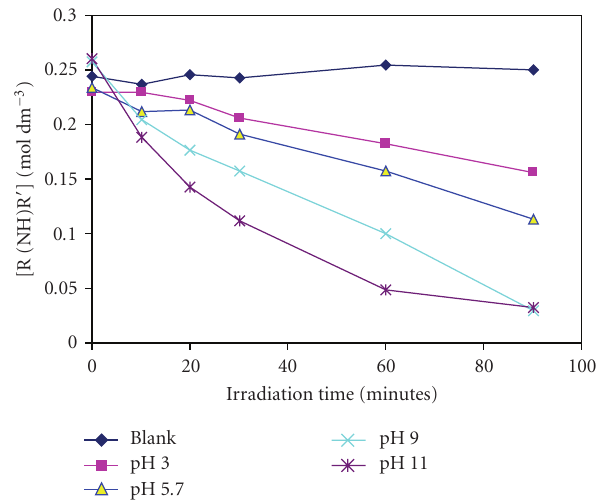
Figure 2: Photocatalytically induced loss of secondary amine functionality (measured using the N-nitroso method, see text) in glyphosate as a function of pH.